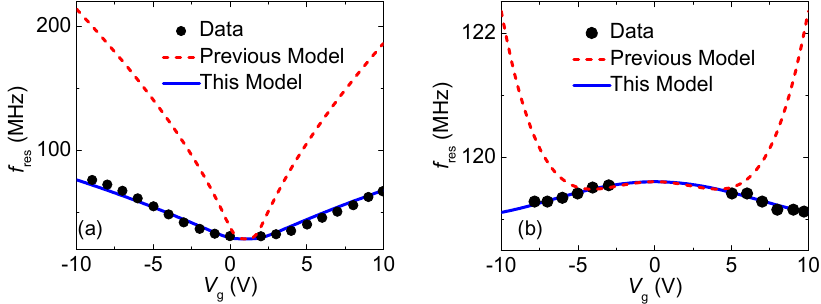
Figure 6. Fitting frequency tuning model to experimental data. The measured data from [6] and fitted data with our modeling (blue solid lines) and previous modeling (red dashed lines) [24] by assuming that built-in strain ε 0 , effective mass ratio, length L , air gap z 0 are ( a ) 0.003%, 3.5, 1.1 μ m 250 nm and ( b ) 0.23%, 5.7, 1.8 μ m 250 nm, respectively.